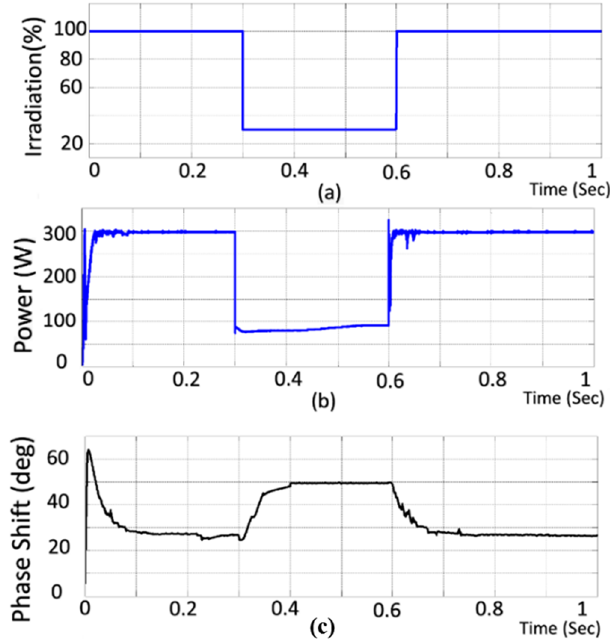
Figure 9. Irradiation step variation (100%-30%-100%) with proposed FFPS predictive MPPT control: ( a ) the irradiation profile ( b ) the PV input power and the maximum power ( c ) the phase-shift change.